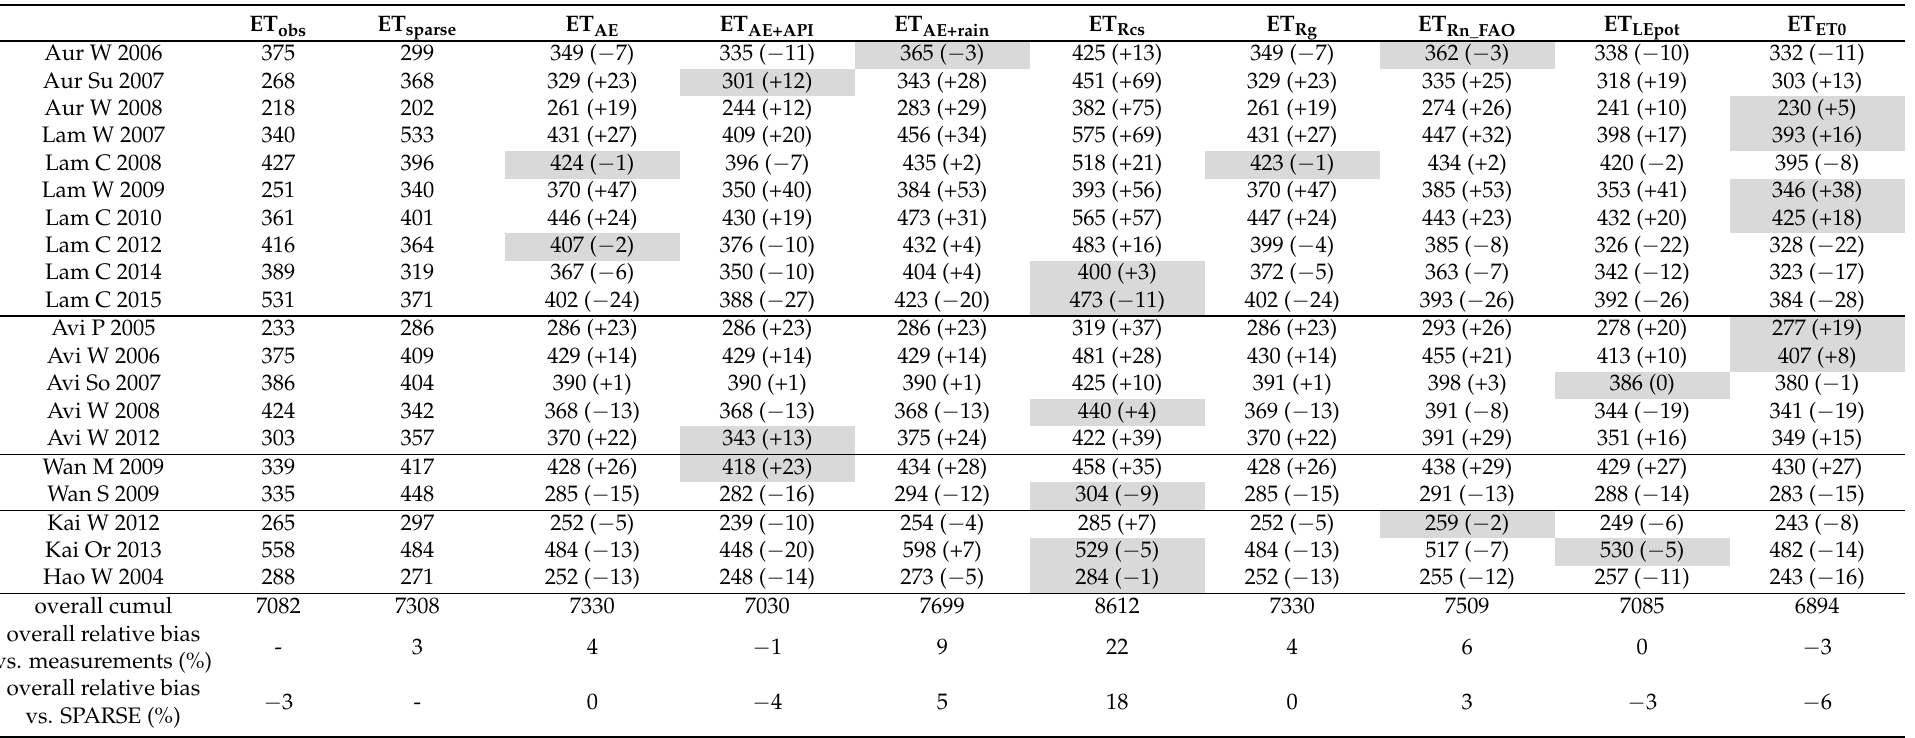
Table A2. Cumulative seasonal evapotranspiration observed (ETobs, mm) and reconstructed (mm) with the different reference quantitiesand error associated (relative bias in %) for